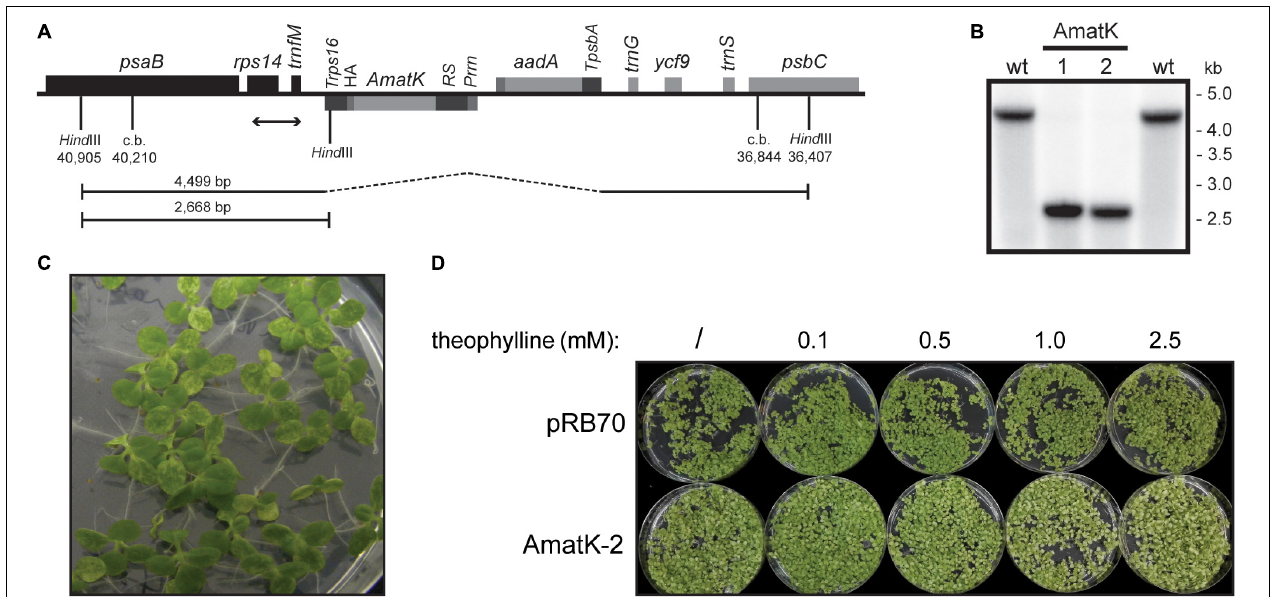
FIGURE 1 | Generation of transplastomic tobacco plants with a riboswitch-induced synthetic matK gene. (A) Schematic map of the transformed plastome containing the aadA cassette and a riboswitch-driven cassette including the matK gene (AmatK). c.b. = construct border. Numbers refer to genome position within the tobacco chloroplast genome (accession Z00044.2). (B) Southern blot analysis to test for integration of the transgenic cassettes. Total DNA was digested with the restriction enzyme Hind III, which generates fragments of 4499 and 2668 bp as indicated by handlebars in (A) . The position of the DNA probe used is shown by a double-headed arrow in (A) . (C) Phenotype of 12 day old seedlings grown in vitro . (D) Seed germination of control plants and AmatK plants on media containing different amounts of theophylline. Plants were photographed after 10 days of growth.